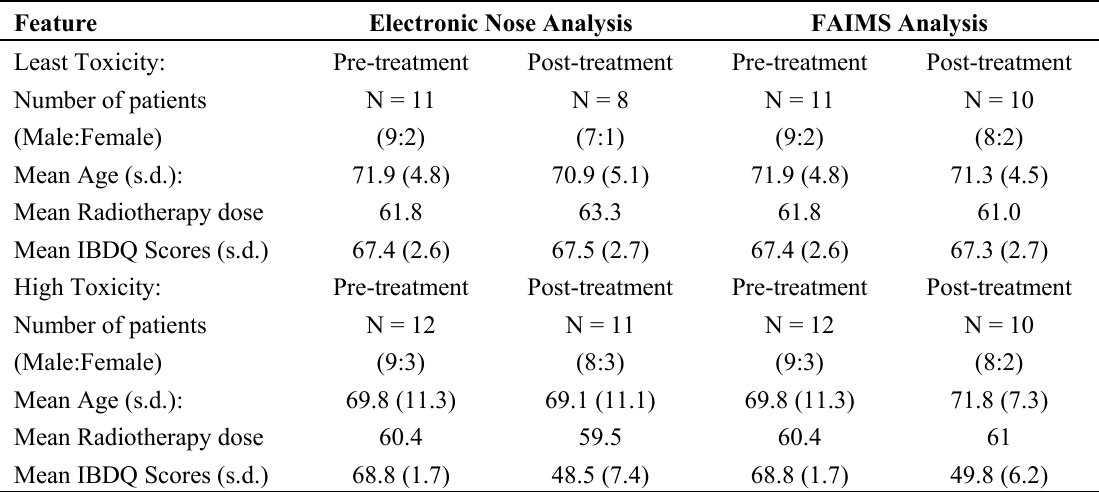
Table 2. Baseline demographic characteristics and treatment features: Groups 1 (low toxicity) and 2 (High